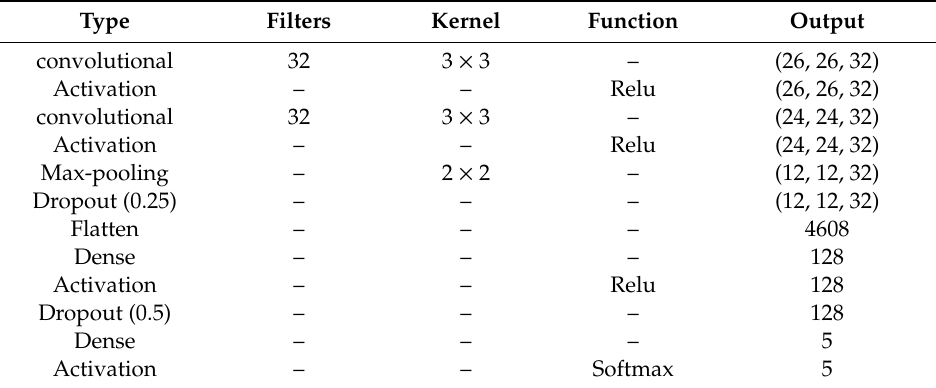
Table 7. Architecture of base and knowledge-transfer